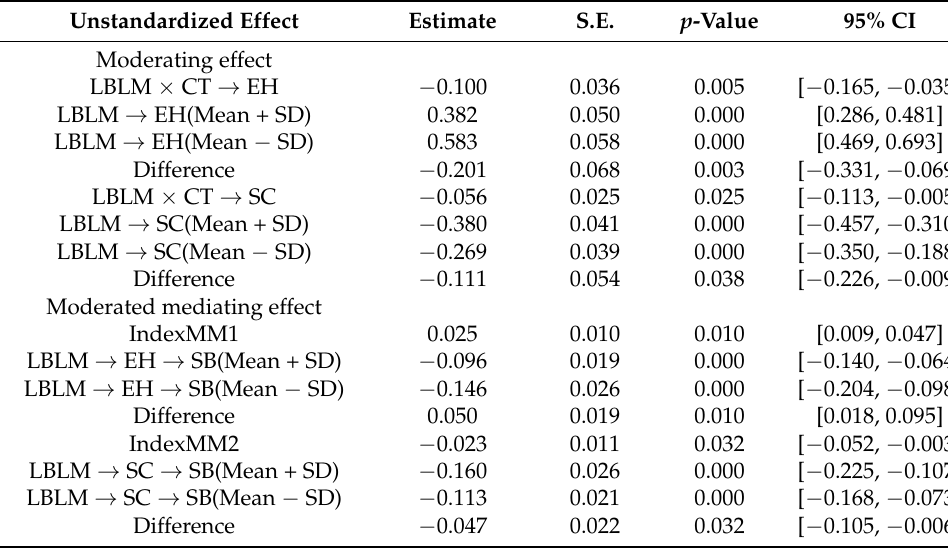
Table 7. Moderating effect and moderated mediating effect results (N =